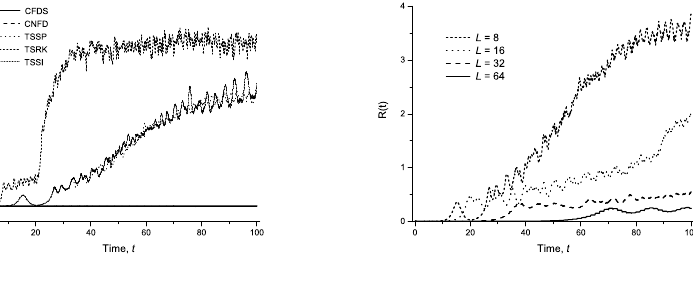
Figure 7. The mean square difference be- tween the absolute values of the soliton so- lution | u s ( x,t ) | and the numerical solutions | u n j | of NLS obtained by TSSP in the space intervals of different